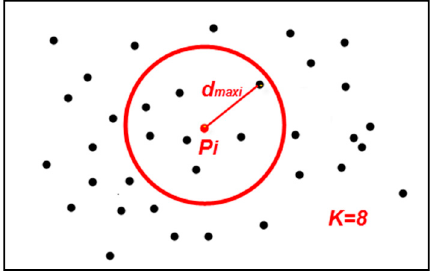
Figure 2. The point 𝑝 (cid:3036) ’s KNN max distance 𝑑 (cid:3040)(cid:2911)(cid:2934)(cid:3036) (𝑘 = 8) .